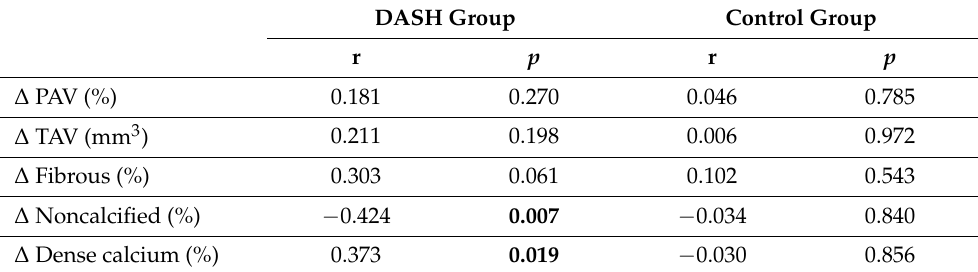
Table 6. Correlation between the change ( ∆ ) in MCP-1 plasma concentration and the change in plaque volume and composition in both study groups. Statistically significant p -values are marked in bold.